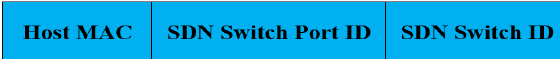
Figure 2. Algorithm and Flow Diagram for IdeA.